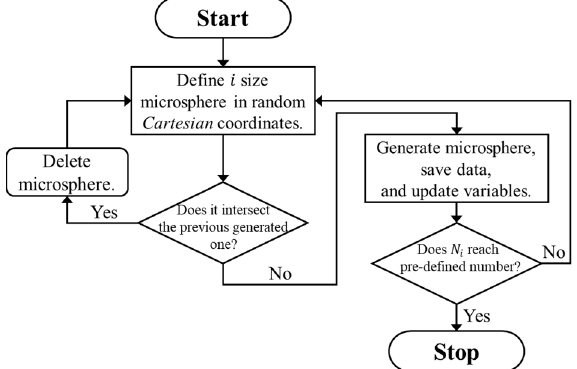
Figure 2. Schematic flow chart of the random sequential adsorption algorithm, where i and N i are the diameter and the number of glass microspheres, respectively.